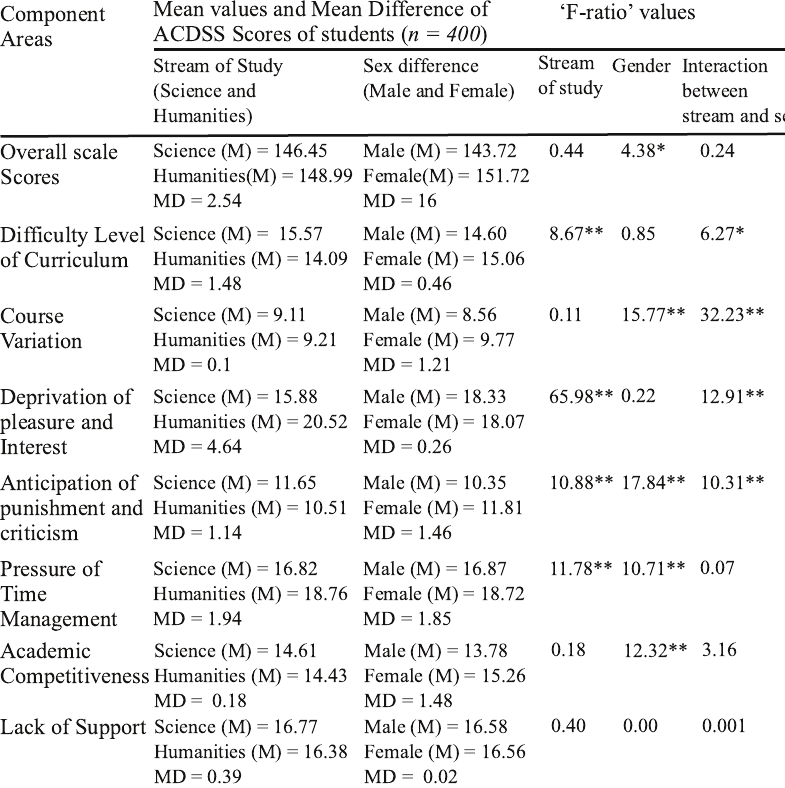
Mean (M), mean difference (MD) and ‘F- ratio’ values for academic career development stress (ACDS) scale scores of students (N = 400) under two different treatment conditions (stream ofeducation and sex ofthe